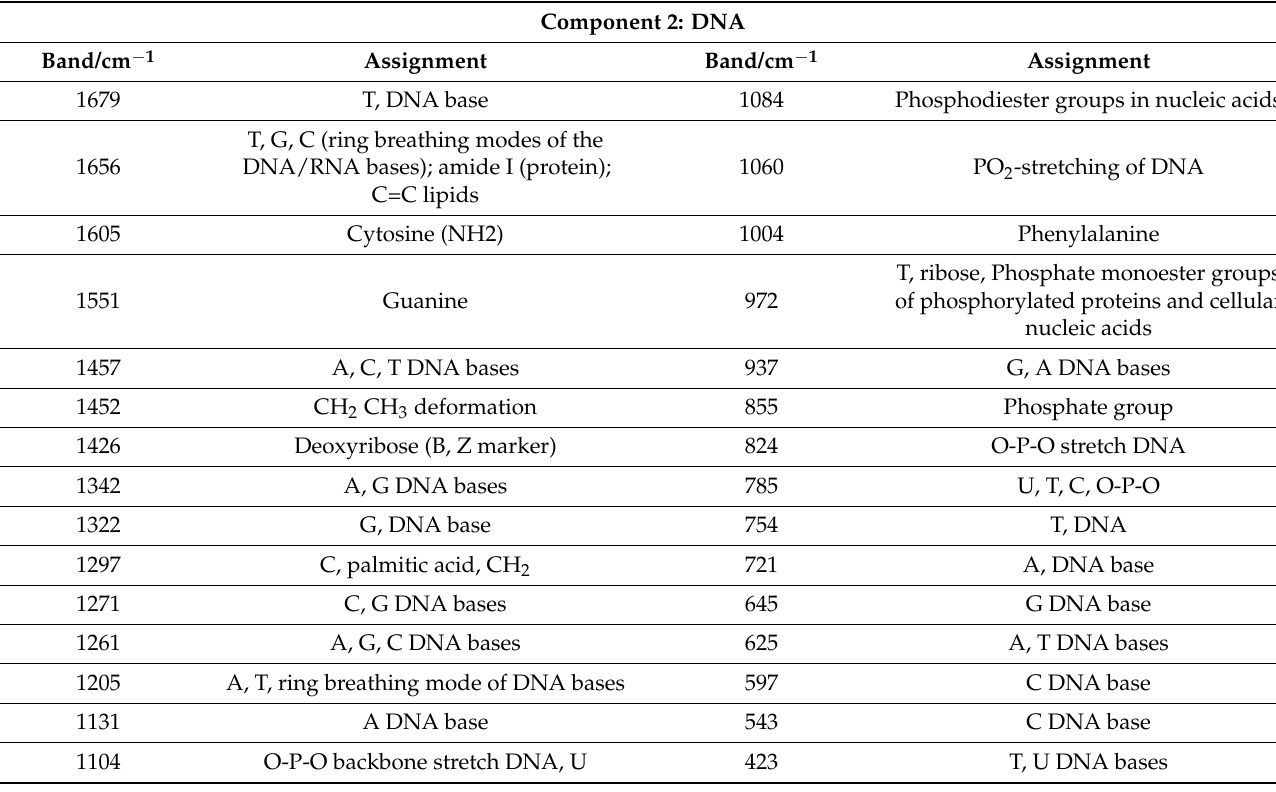
Table 2. Bands and assignments of molecular component number 2, extracted from MCR analysis of HAp calcification shown in Figure 2. Assignments were based on the literature